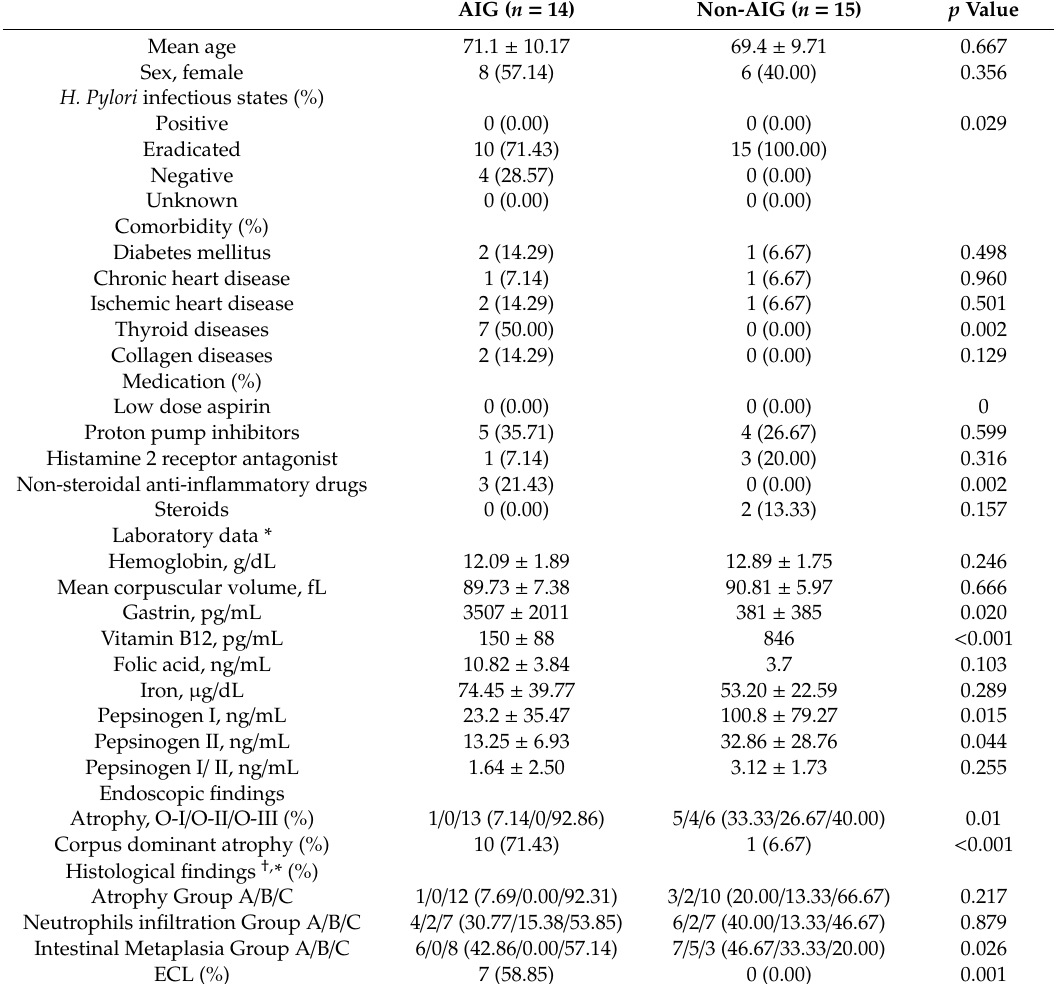
Table 2. Characteristics between AIG and non-AIG in patients undergoing gastric microbiota